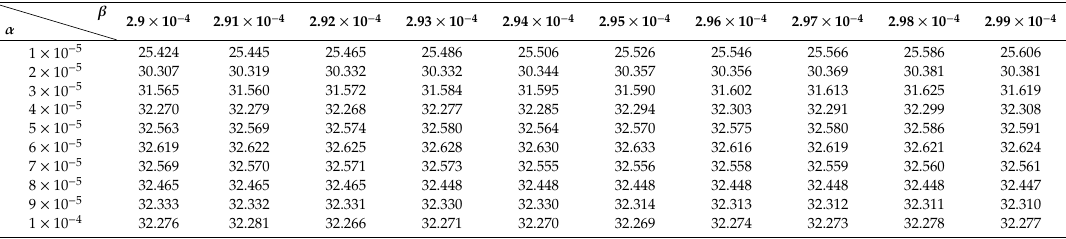
Table 3. IFs2 with di ff erent α , β corresponding to SNR data.